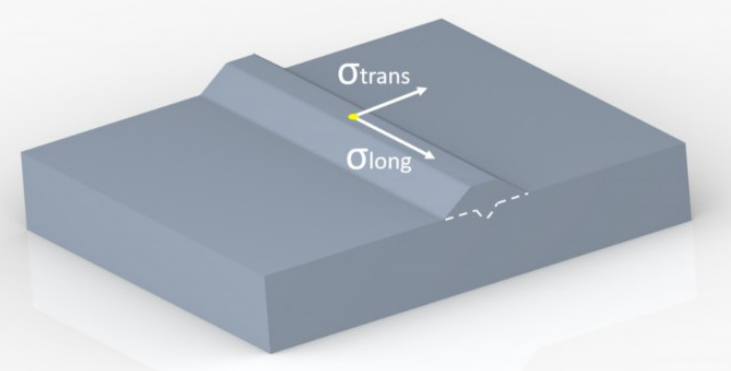
Figure 5. Residual stress components determined by X-ray diffraction and the location of measurement. σ trans and σ long correspond to the transversal and longitudinal stresses, respectively.